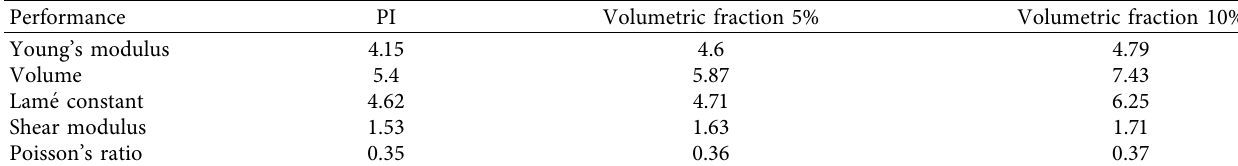
Table 4: Single cell model and single cell mechanical properties.